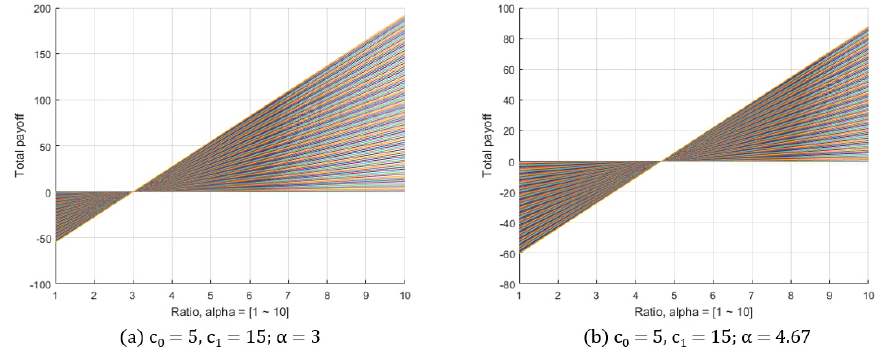
Figure 2. Open two-sided platform optimization